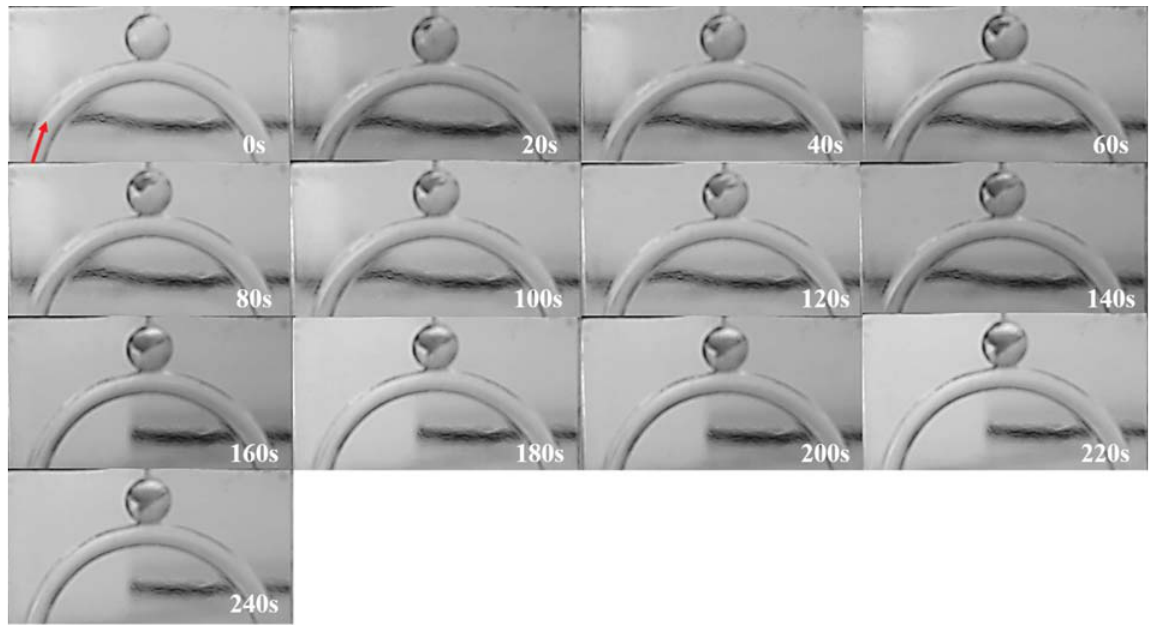
TH Open Vol. 5 No. 2/2021 © 2021. The